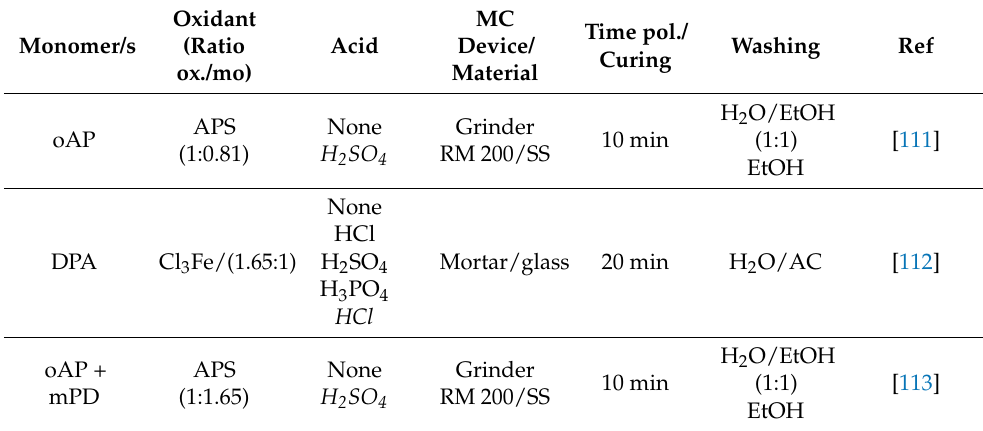
Table 5. Summary of MCP conditions for aromatic amines, which give polymer chains different than the PANI backbone. The acids produced during the reaction are shown in italics.